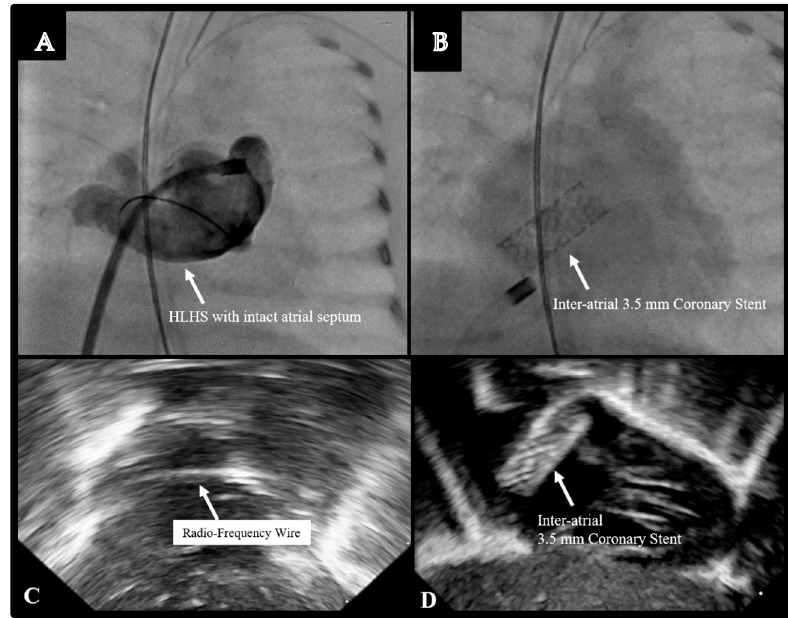
Figure 4. Inter-atrial stent placement in an 890 g infant with Hypoplastic Left Heart Syndrome with an Intact Atrial Septum. ( A ) Angiogram of the intact atrial septum. ( B ) Placement of a coronary stent across the atrial septum. ( C ) Echocardiographic image of the radio-frequency wire across the atrial septum. ( D ) Echocardiographic image of the coronary stent.